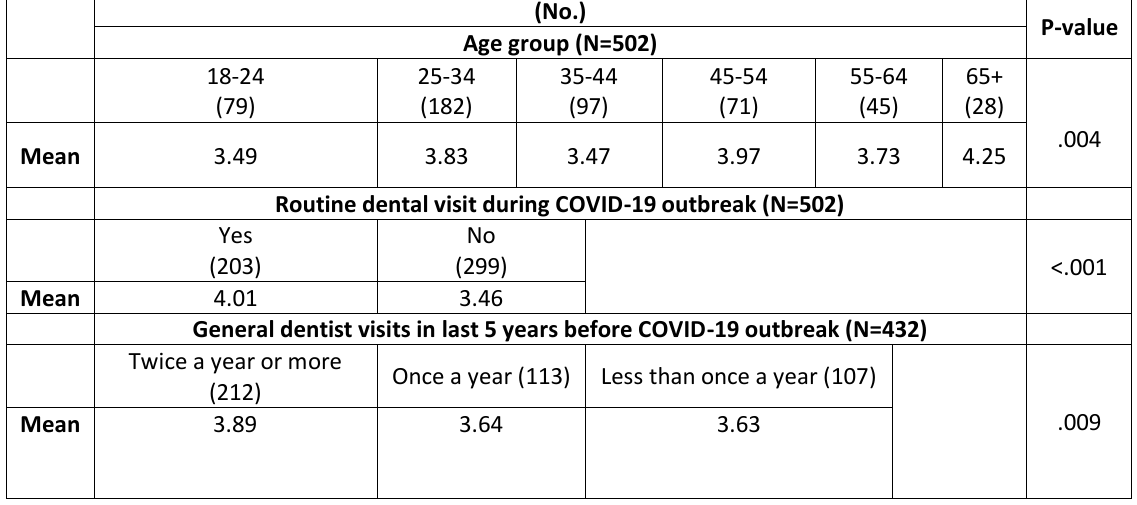
Table 4 Patients’ concerns about contracting COVID-19 during a dental visit for different US census regions, age, and gender.